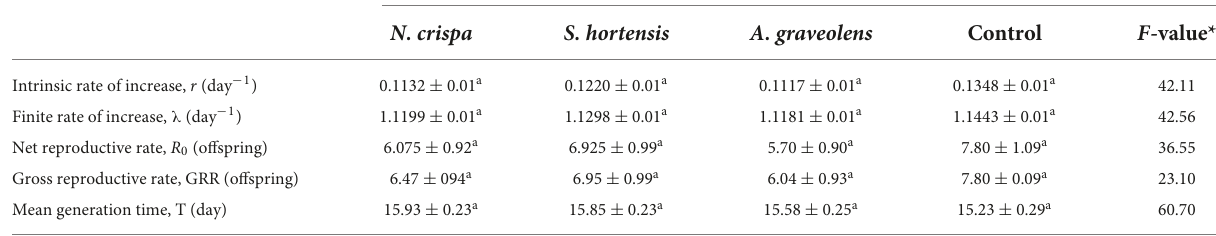
TABLE 5 Mean ( ± SE) population parameters of the females of Amblyseius swirskii from control and treatments with N. crispa , S. hortensis , and A. graveolens oils.